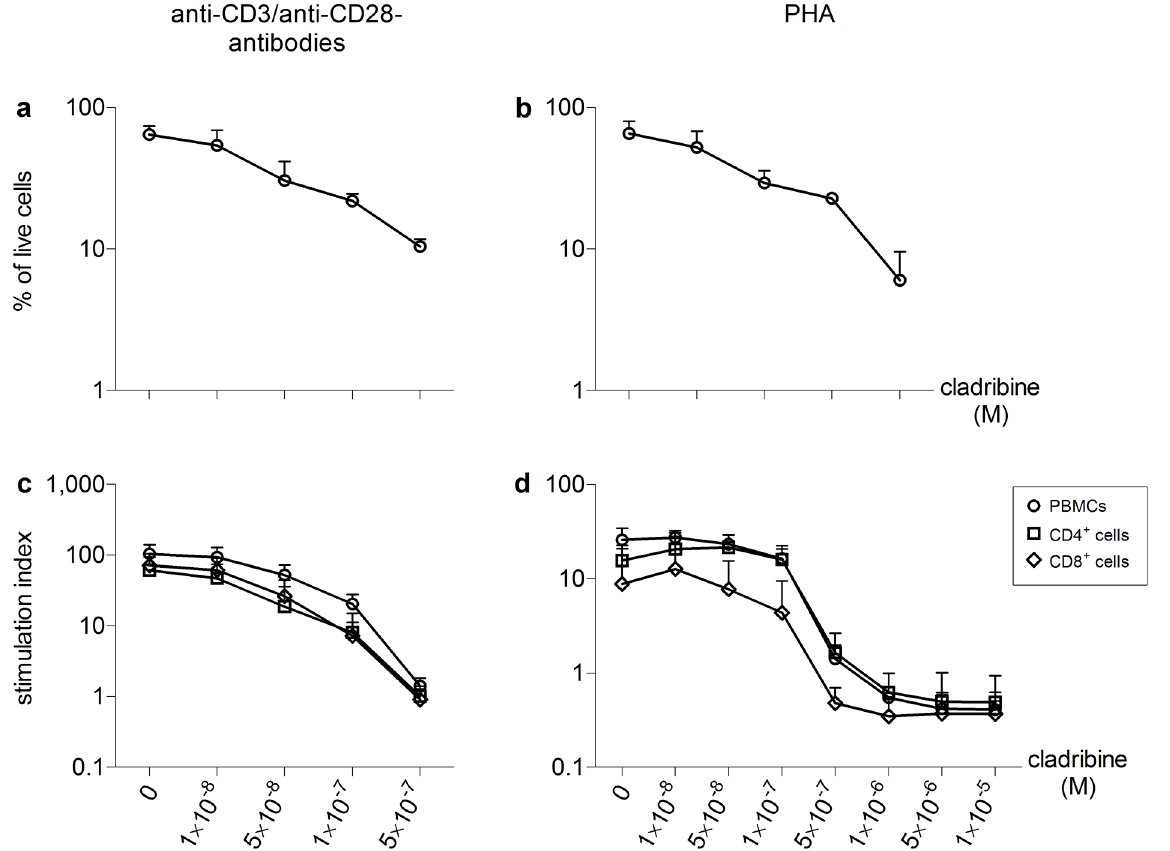
Fig 1. In vitro effects of cladribine on cell survival of PBMCs and proliferation of PBMCs, CD4 + cells and CD8 + cells Human immune cells were stimulated with anti-CD3/anti-CD28 antibodies (a, n = 4; c, n = 6) or PHA (b, n = 4; d, n = 3) in the absence or presence of cladribine (1×10 − 8 M to 1×10 − 5 M) for 72 h. Determination of cell survival in PBMCs (a, b) was performed by standard trypan blue exclusion method. Proliferation was determined separately in PBMC, CD4 + cells and CD8 + cells (c, d) by the incorporation of tritiated thymidine. Stimulation indices were calculated as the ratios of the counts per minute of stimulated samples to unstimulated and untreated samples. Data are depicted as mean + standard deviation (SD).